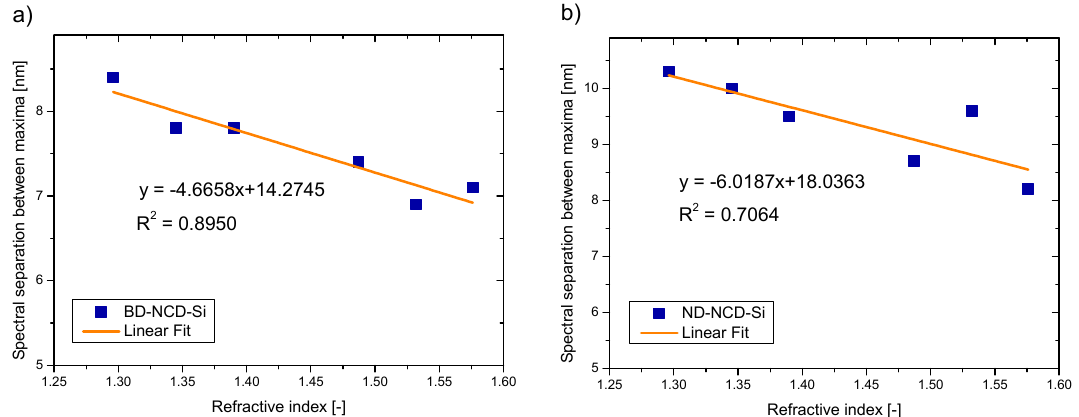
Figure 6. Measurement results: spectral separation between maxima as a function of refractive index for wavelength equal to 1290 nm ( a ) BD-NCD-Si, ( b ) ND-NCD-Si. The values of correlation coe ffi cient R 2 and sensitivity S for each sensor working at central wavelength of 1290 nm are presented in Table 2. The sensitivity can be directly found from the slope of the linear fit [9]. The values of R 2 parameter in the range of 0.7–0.9 indicate high positive / negative correlation, while values higher than 0.9 mean very high positive / negative correlation [23]. Table 2. Correlation coe ffi cient (R 2 ) and sensitivity (S) values for sensors working at 1290 nm. Parameters BD-NCD-Si ND-NCD-Si R 2 0.8950